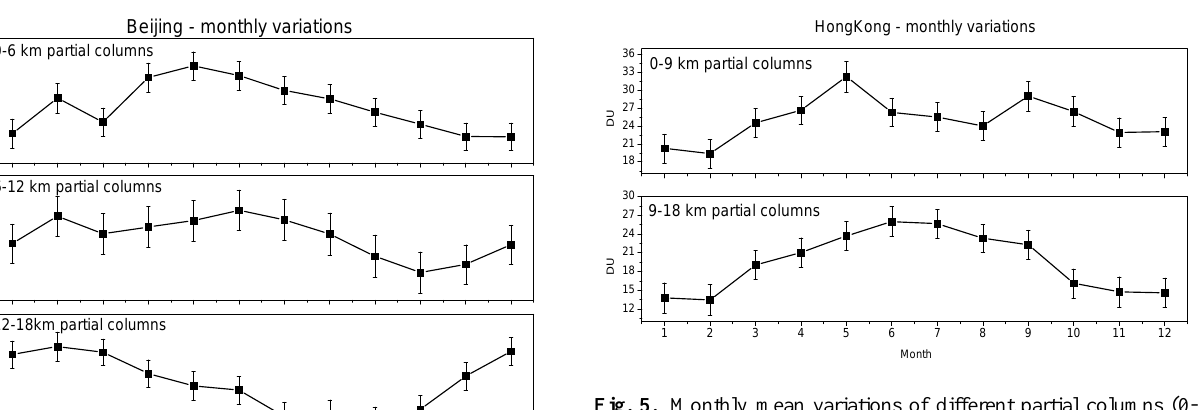
Figure 5. Monthly mean variations of different partial columns (0-9 km column, and 9-18 km column) retrieved from IASI observations over Hong Kong in 2008. Figure 3. Monthly mean variations of different partial columns (0-6 km column, 6-12 km column and 12-18 km column) retrieved from IASI observations over Beijing in 2008.